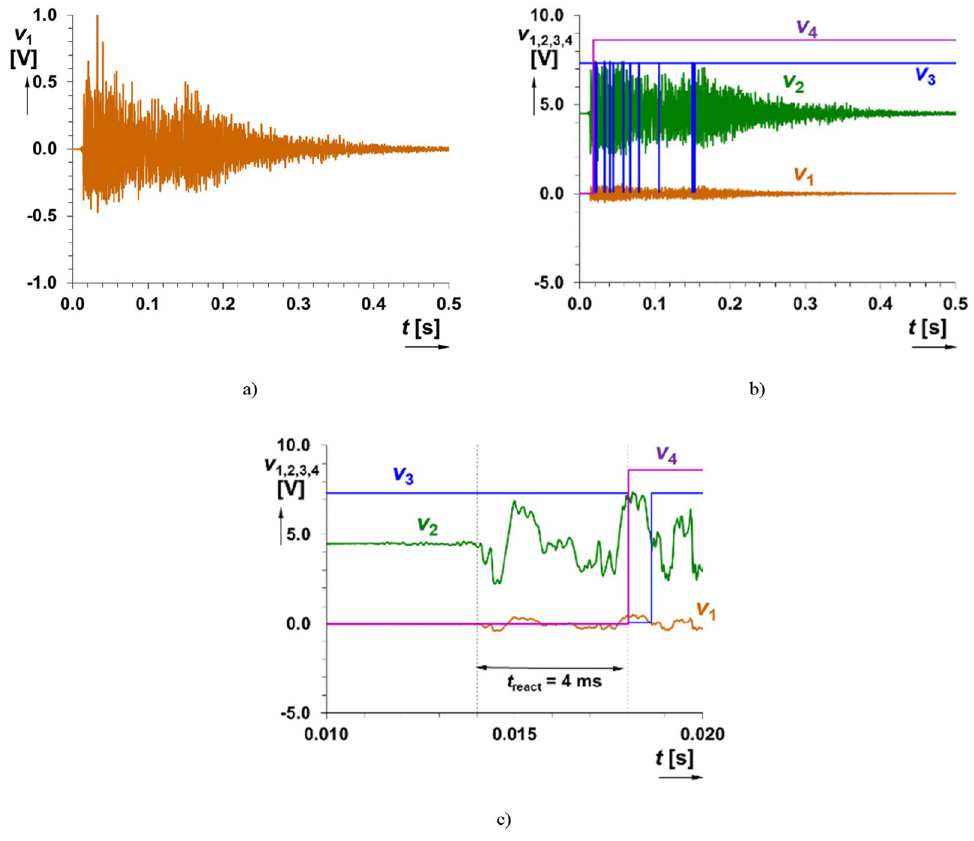
Figure 10. Simulation of time domain response of the readout system on signal pattern of a gunshot (threshold of reaction set to 0.33 V): ( a ) detail on the signal at the input of the system ( v 1 ( t )), ( b ) all indicated outputs of the system and ( c ) detail on initialization.